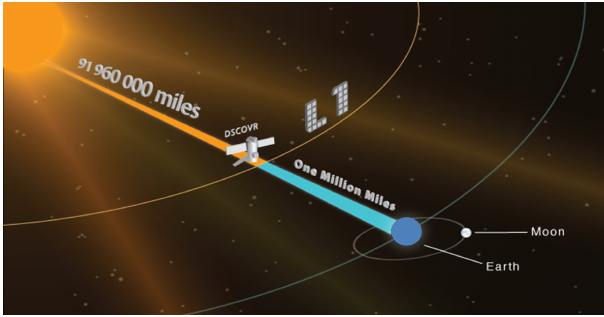
Figure A1. An illustration of DSCOVR’s Lagrange 1 orbit.